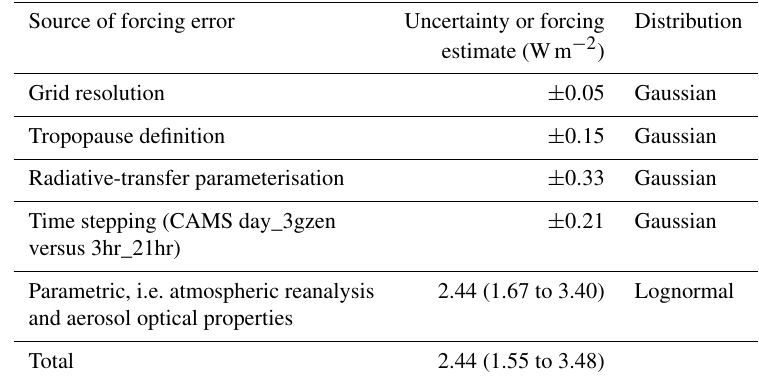
Table 7. Combined parametric and structural uncertainty in net tropopause instantaneous radiative forcing for 2003.